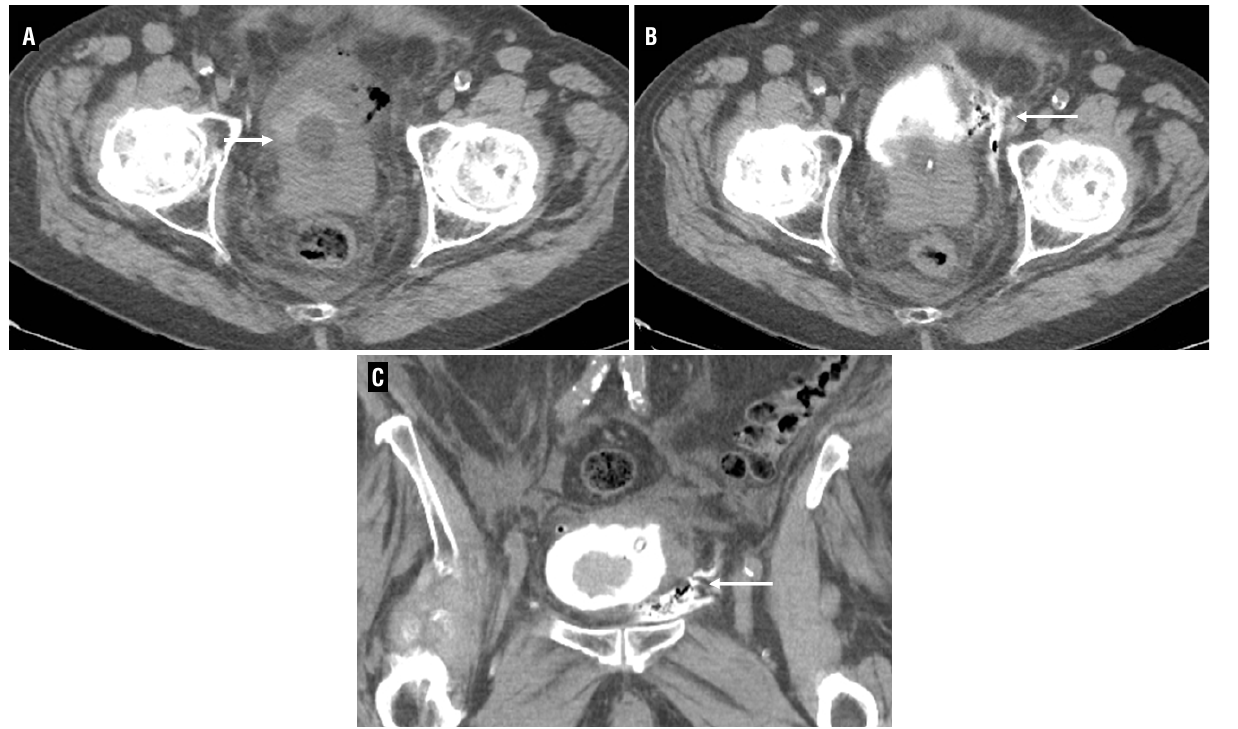
Figure 2: A, B and C - CT urogram performed on postoperative day one following TuRBT. (A) Axial pre contrast image shows high density material within the bladder, surrounding the catheter balloon compatible with intravesical clot. Gas is also pre- sent along the left lateral bladder. (B) After retrograde administration of contrast, axial CT image shows immediate pooling of contrast outside of the bladder compatible with extraperitoneal perforation (white arrow). (C) Coronal MPR image shows the irregular collection of contrast extravasation along the left inferior lateral margin of the bladder (white